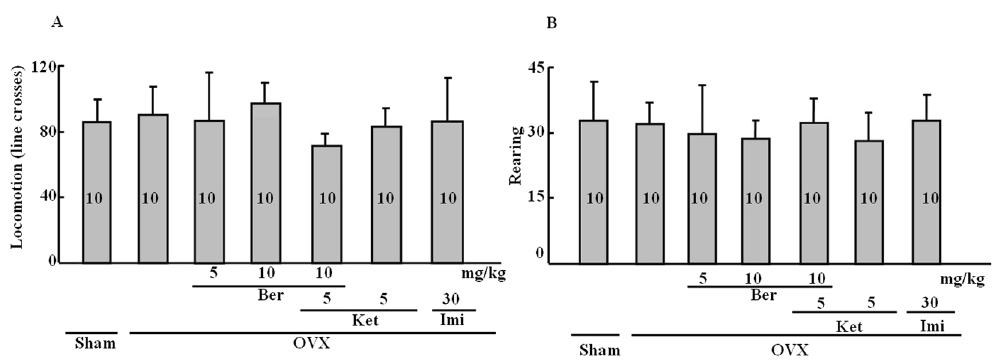
Figure 2. Locomotor behavior and rearing behavior in the open field. ( A ) Locomotor behavior (number of line crosses) in the open field. ( B ) Rearing behavior (frequency) in the open field. Group conditions are indicated by abbreviations, and doses by numbers: Sham (sham treatment), OVX (ovariectomy), Ber (berberine, 5 or 10 mg/ kg), Ket (ketanserin, 5 mg/kg) and Imi (imipramine, 30